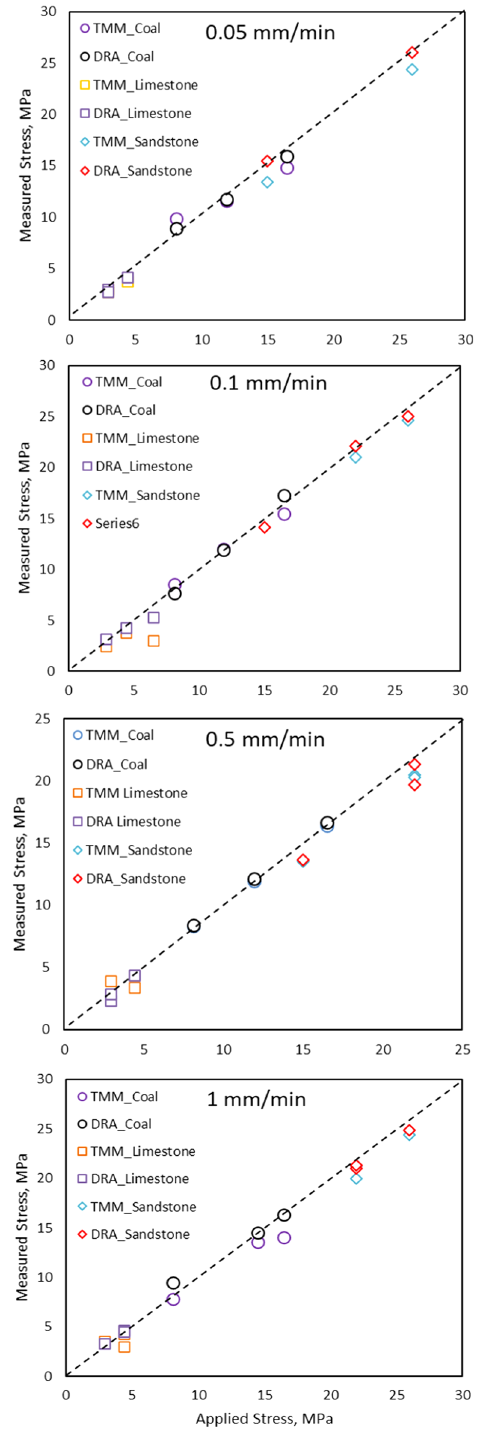
Fig. 12 TMM curves for a coal specimen tested under four different loading/displacement rates